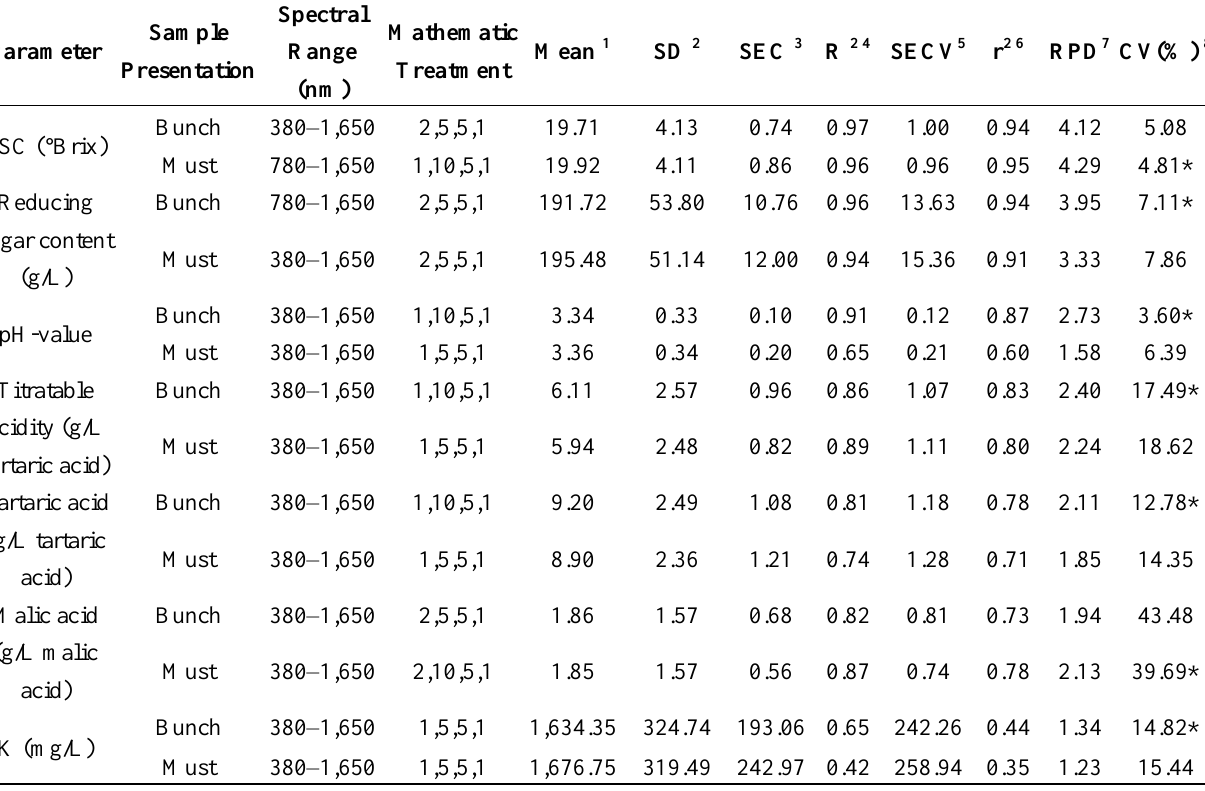
Table 2. Calibration statistics for the models obtained for predicting soluble solid content (SSC), reducing sugar content, pH-value, titratable acidity, tartaric acid, malic acid and potassium content for the different sample presentations and spectral ranges studied (calibration set, n = 251 samples except for potassium cation, n = 104) using MPLS